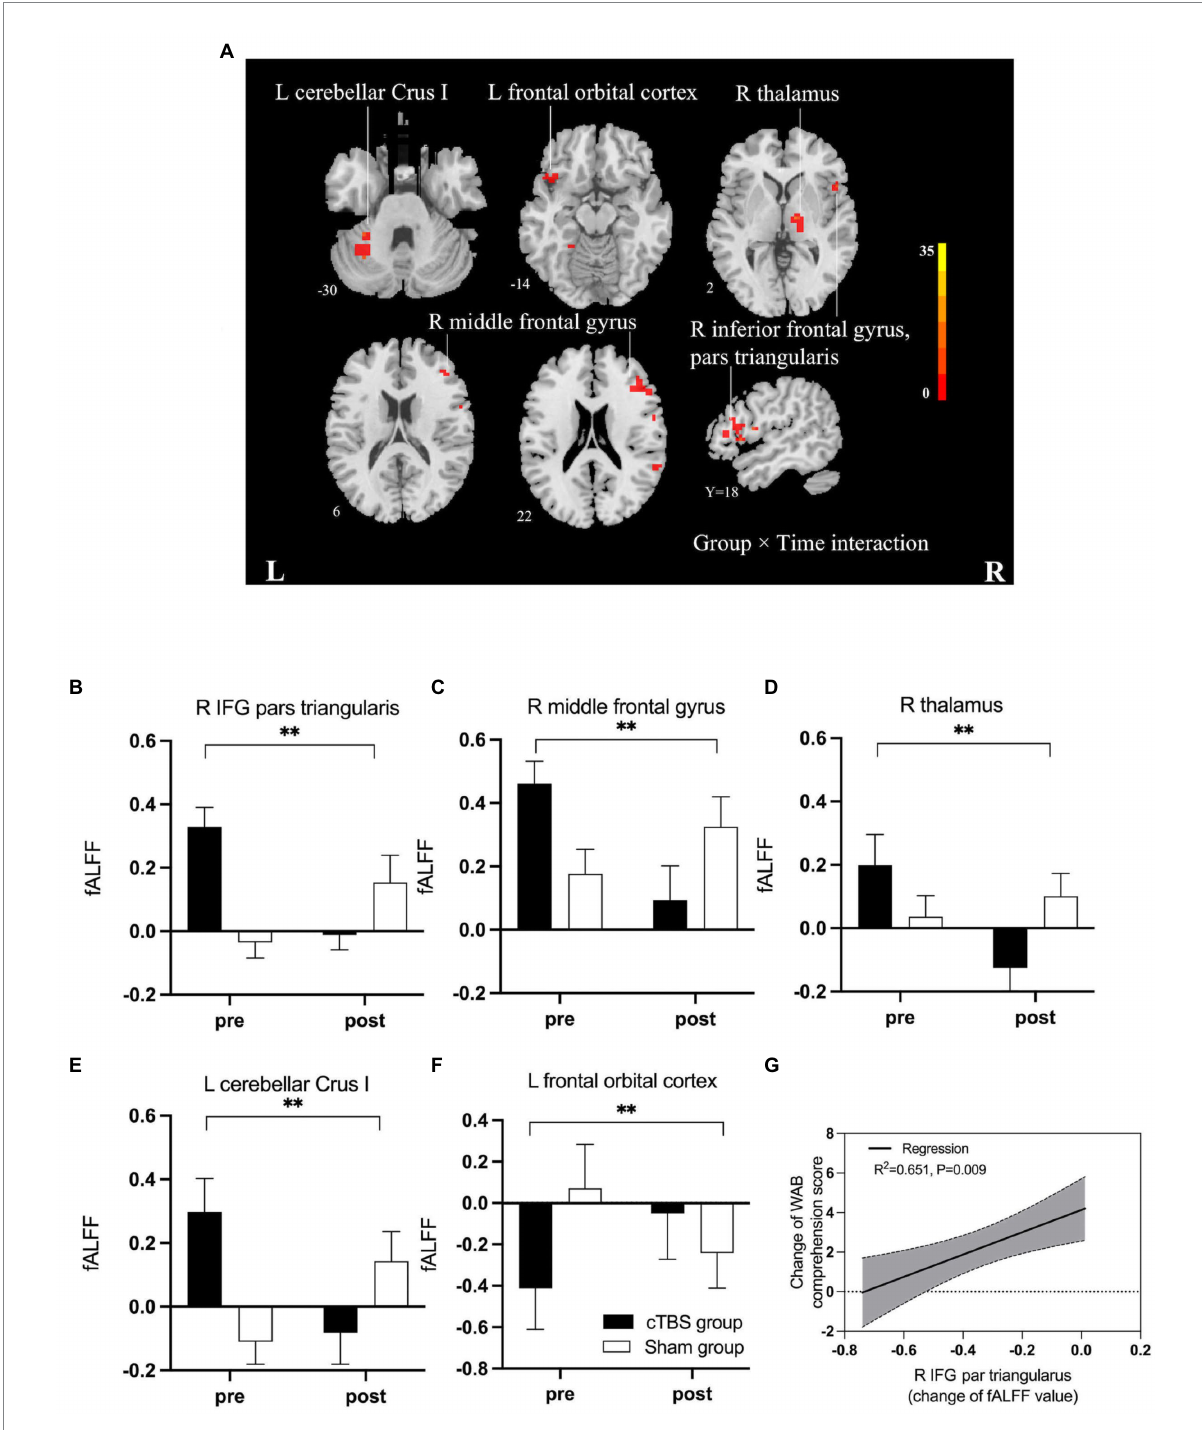
FIGURE 4 (A) F map of differences in spontaneous activity pre-and post-treatment between the cTBS group and sham group. Brilliant colors (red to bright yellow) indicate a greater significant difference over pre-and post-treatment between the cTBS and sham groups (group × time interaction). (B–F) Fractional amplitude of low-frequency fluctuations (fALFF) decreased significantly after cTBS in the right pars triangularis, left cerebellar crus I, right middle frontal gyrus, and right thalamus and increased significantly after cTBS in the left orbitofrontal cortex. We used a 2-factor mixed-effects ANOVA. ** indicates p < 0.001 in (B–F) . Bars show means, and error bars represent the standard error of the mean (SEM). (G) The regression analysis showed a significant linear correlation between changes in fALFF in the right pars triangularis and changes in the WAB comprehension score. IFG, inferior frontal gyrus; WAB, Western Aphasia